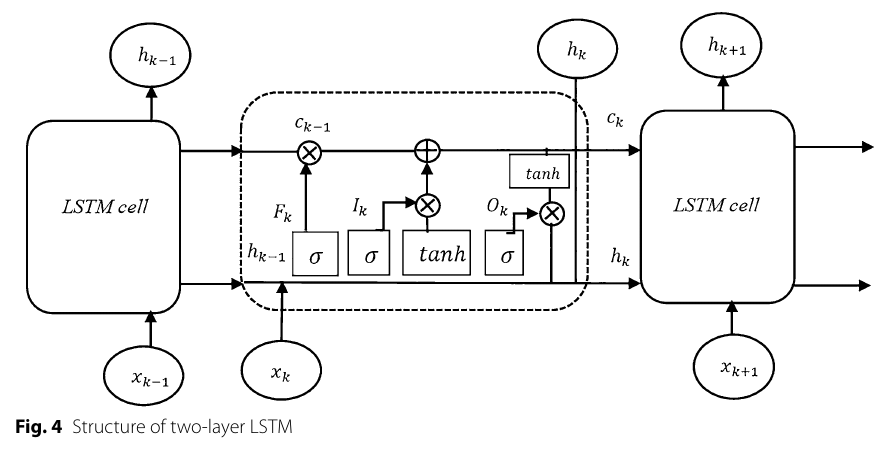
Fig. 4 Structure of two-layer